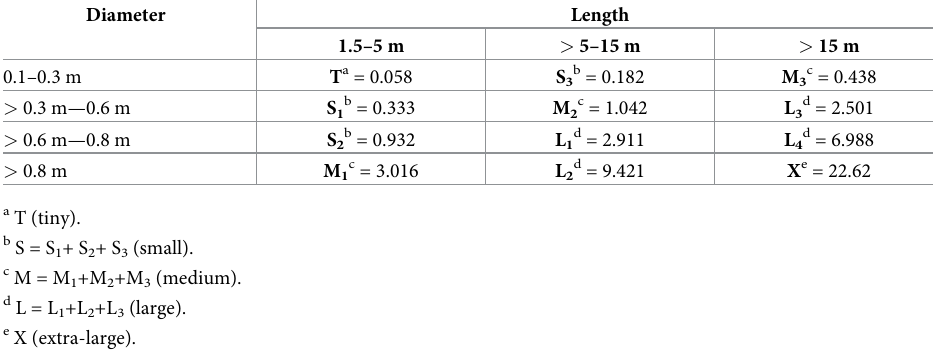
Table 2. The twelve wood size classes. Classes are described according to length and diameter and their respective mean nominal volume calculated from Eq